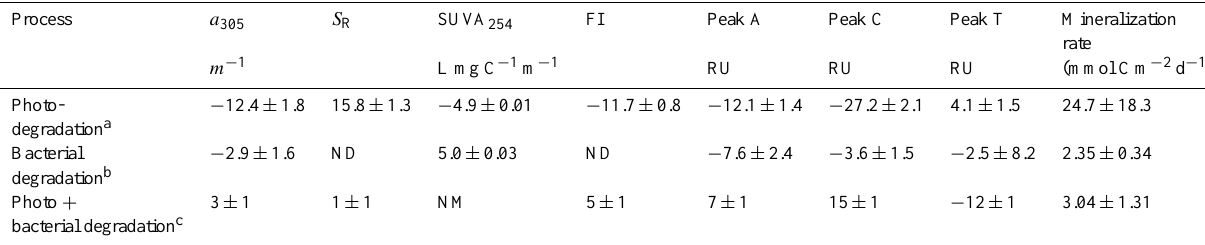
Table 4. Effect of sunlight and bacteria on CDOM, FDOM and DOM